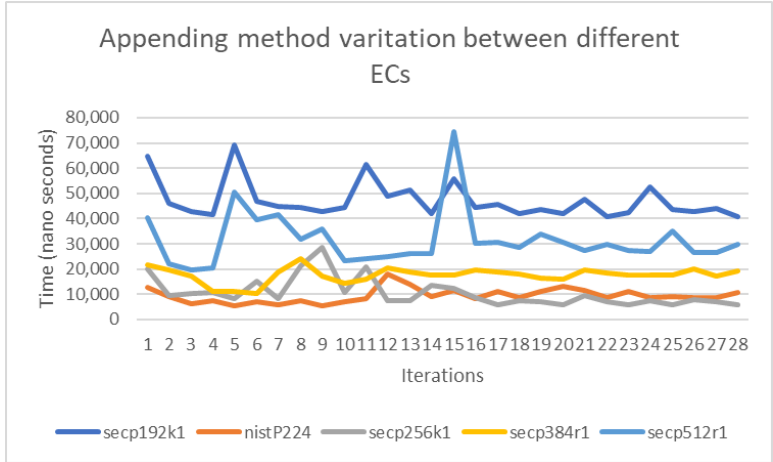
Figure 17. The variation between the set of ECs in the concatenation method.